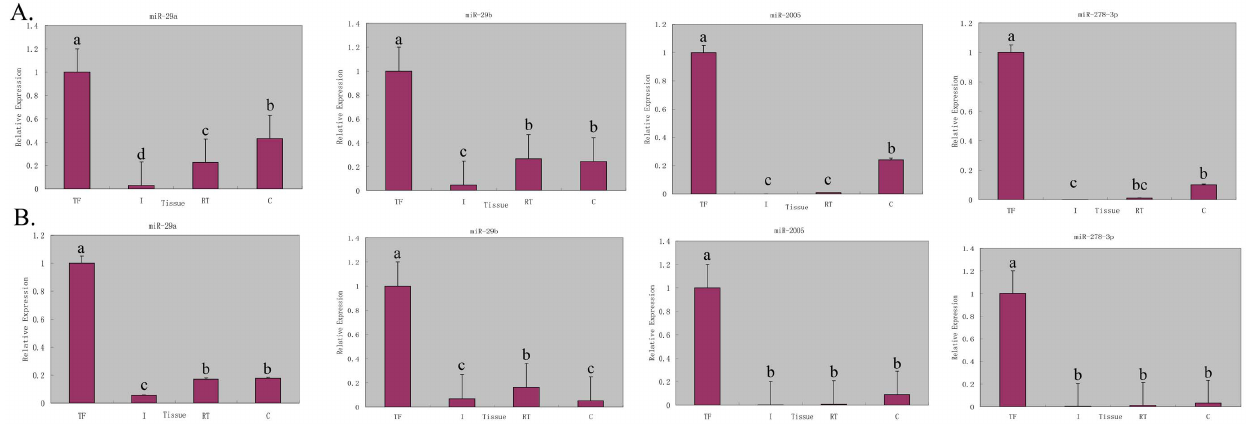
Figure 6. Quantitative realtime PCR analysis of the expression of miR-29a, miR-29b, miR-2005 and miR-278-3p in different tissues of sea cucumber. The tissues are abbreviated as follows: TF, tube foot; I, intestine; RT, respiratory tree, and C, coelomocytes. A: qRT-PCR using b - actin as the reference gene. B: qRT-PCR using Cytb as the reference gene. Bars are shown as mean 6 standard deviation. Bars with different superscripts indicate that they are significantly different from each other ( p ,